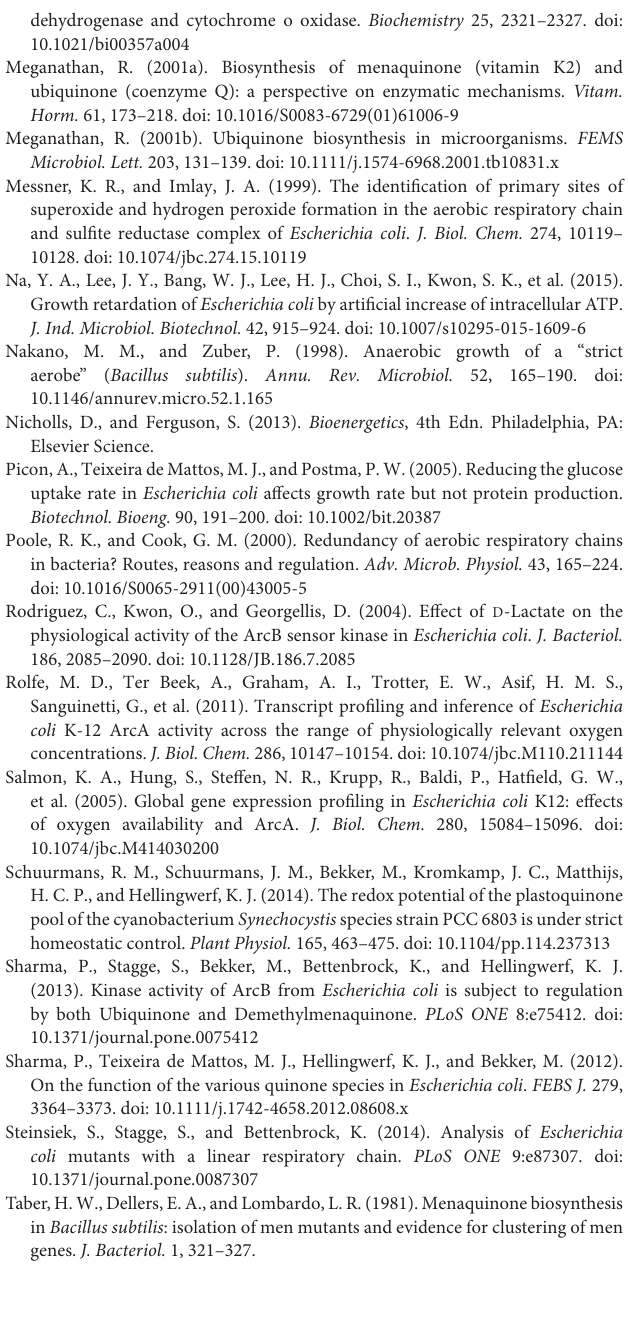
Taber,H.W.,Dellers,E.A.,andLombardo,L.R.(1981).Menaquinonebiosynthesis in Bacillus subtilis : isolation of men mutants and evidence for clustering of men genes. J. Bacteriol. 1,